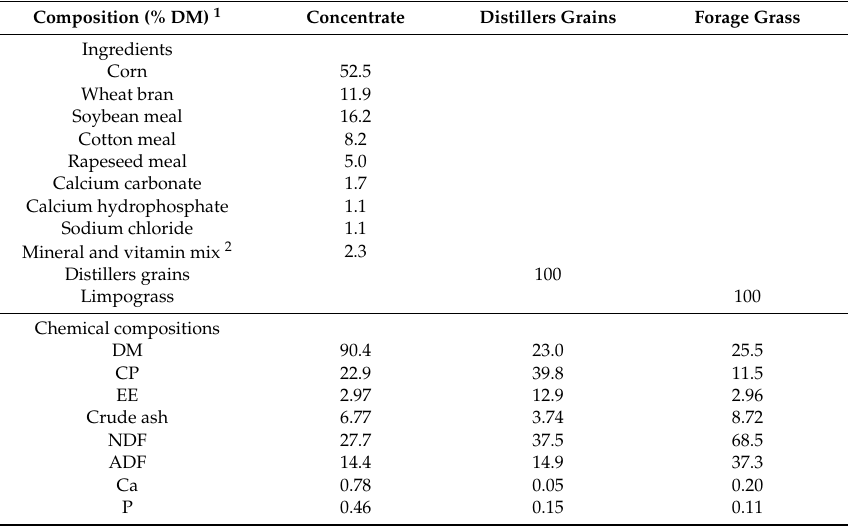
Table 1. Ingredients and chemical compositions of the experimental